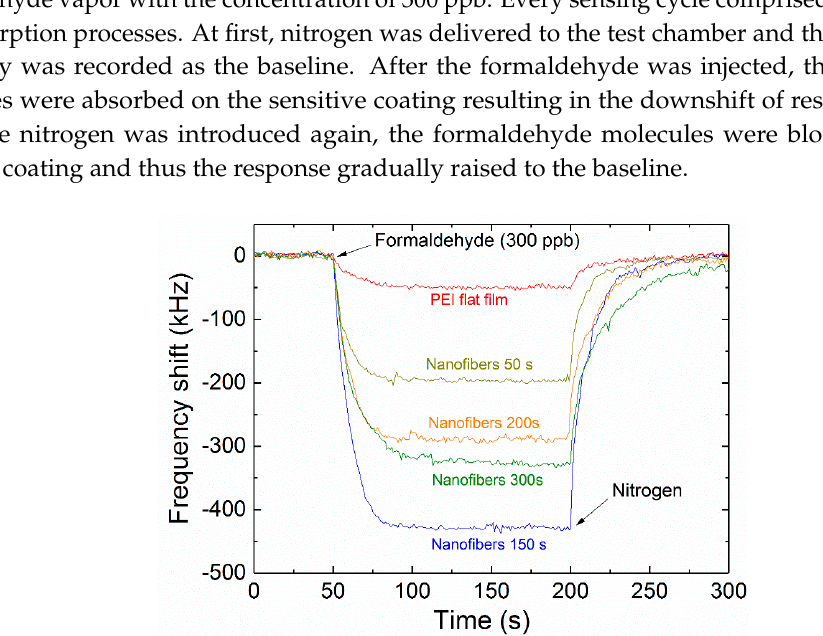
Figure 6. The changes of ( a ) resonant frequency and ( b ) Q factor of the PEI nanofibers-coated FBAR devices for different deposition times.